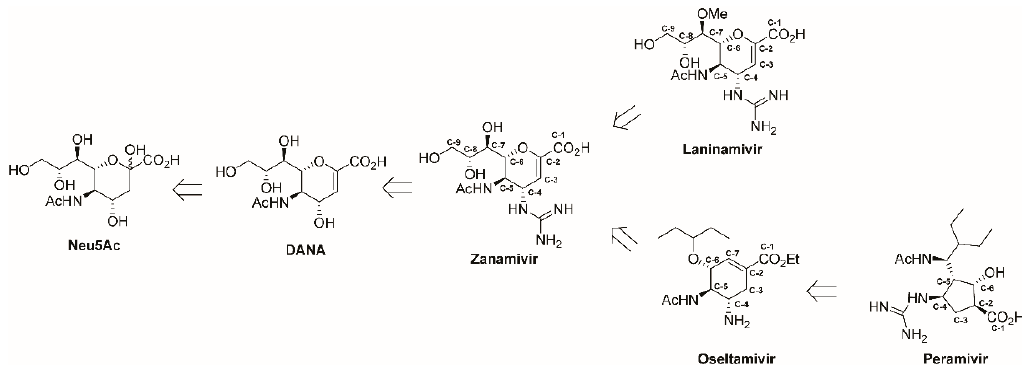
Figure 2. Retrosynthetic analysis of the evolution of influenza neuraminidase inhibitors.